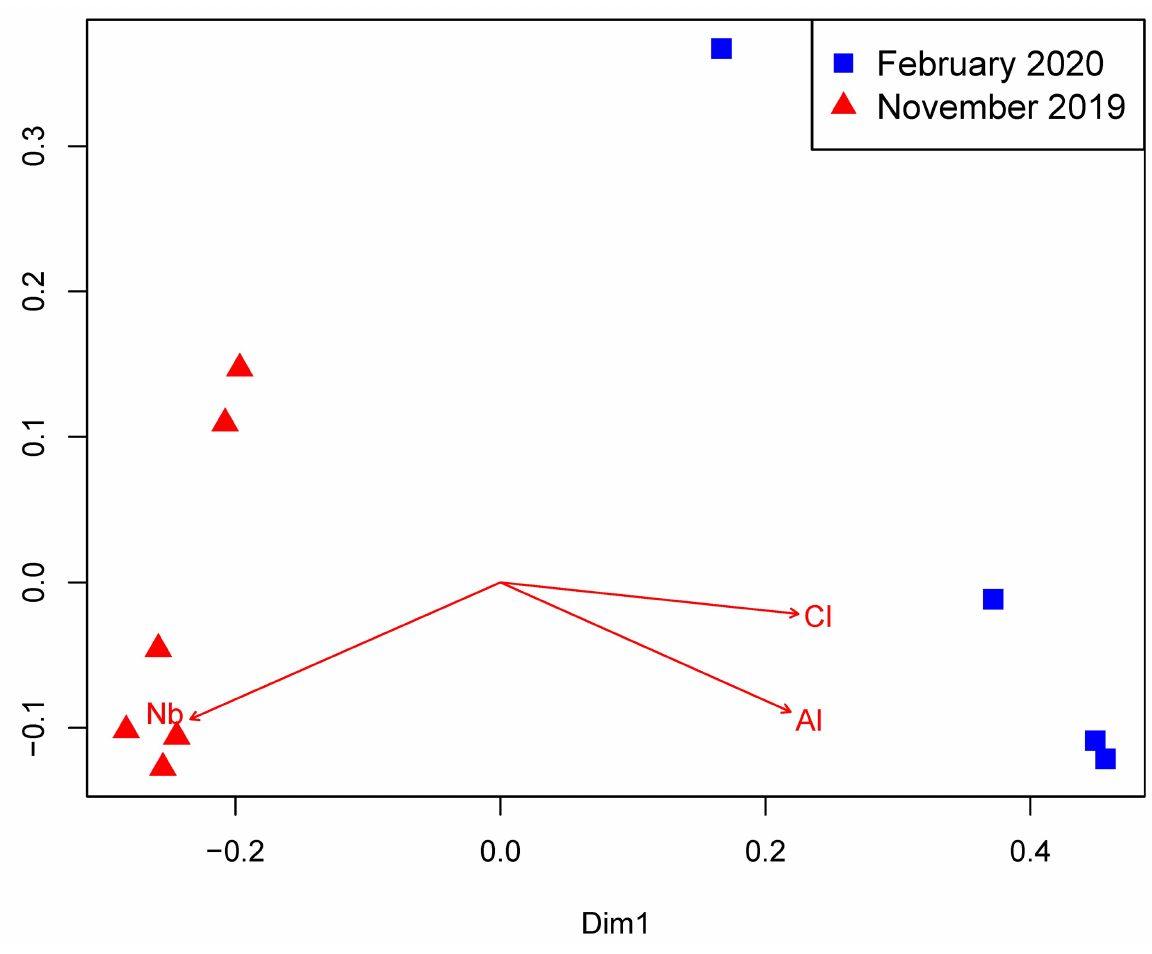
Figure 9. PCoA (principal coordinate analysis) plot of eukaryotic communities. Environmental factors that have significant correlation with the ordination (with p value lower than 0.01 and R-square value larger than 0.5) based on permutation tests are shown as red